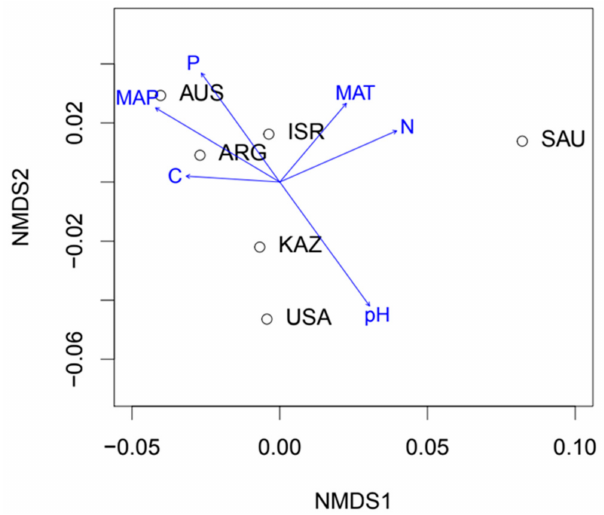
Figure 3. NMDS ordination showing variation in AM fungal phylogenetic community composition for desert samples. The ordination was calculated using mean pairwise phylogenetic distance be- tween VT in samples. Arrows show significant correlations of climatic and soil–chemical parameters with the NMDS